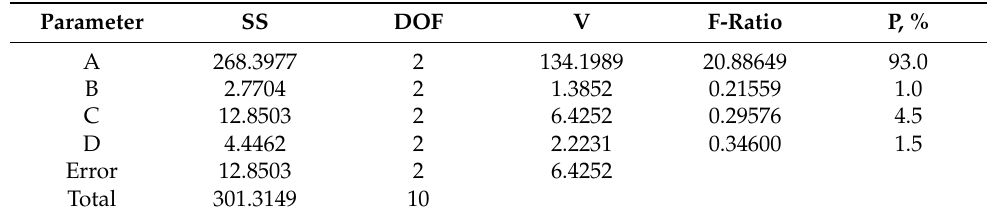
Table 8. Analysis of variance for graphite content in the